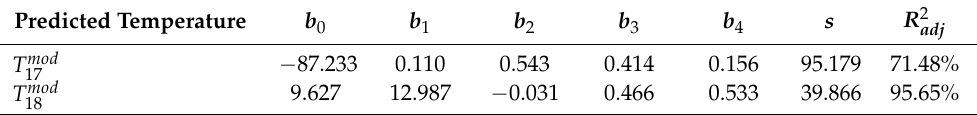
Table 7. Coefficients of modified regression models for coal temperatures and values of a multiple coefficient of determination and a standard error of the estimate (Source: own